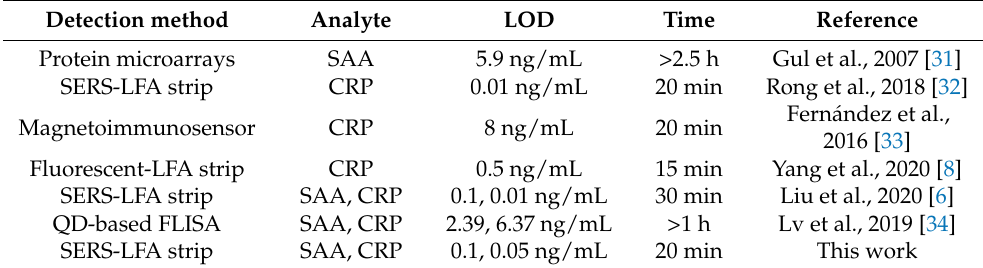
Table 1. Comparison of our proposed SERS-LFA strip with other reported SAA/CRP detection methods. Detection